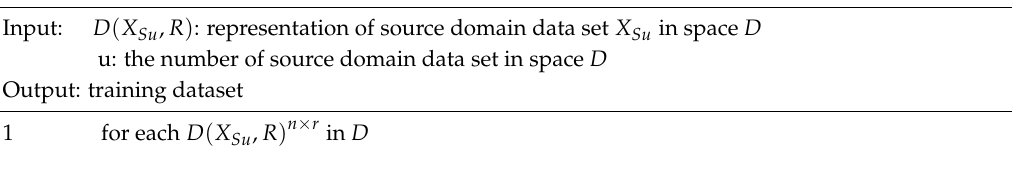
Algorithm 3. Selection of multi-source